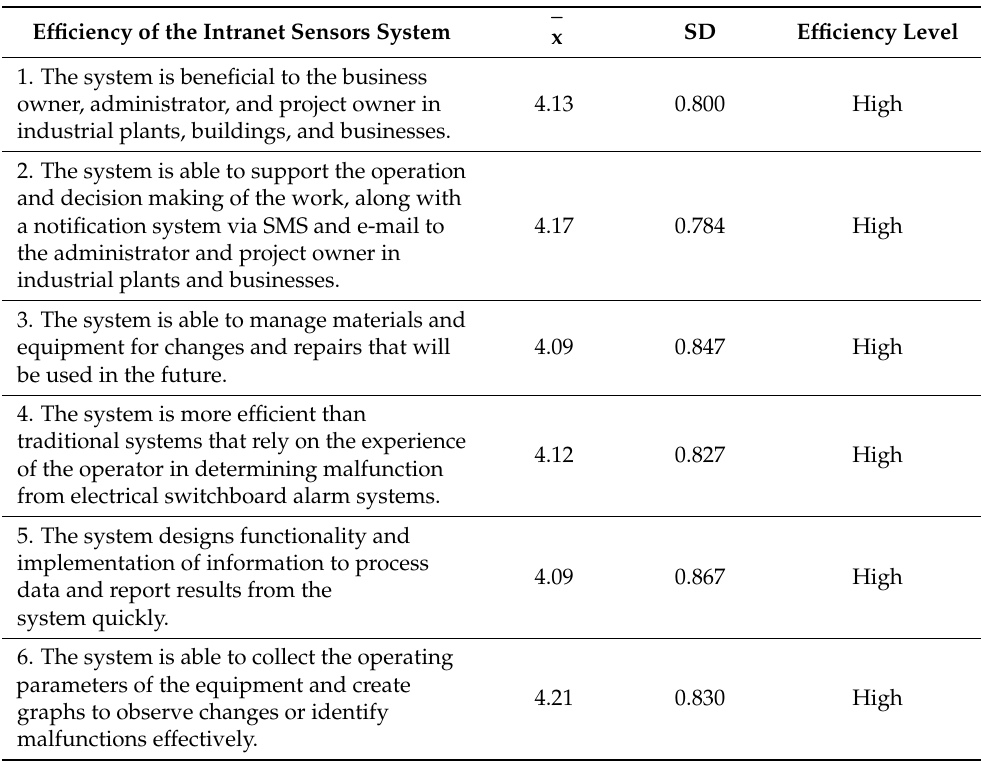
Table 1. Acceptance test results of intranet sensors system